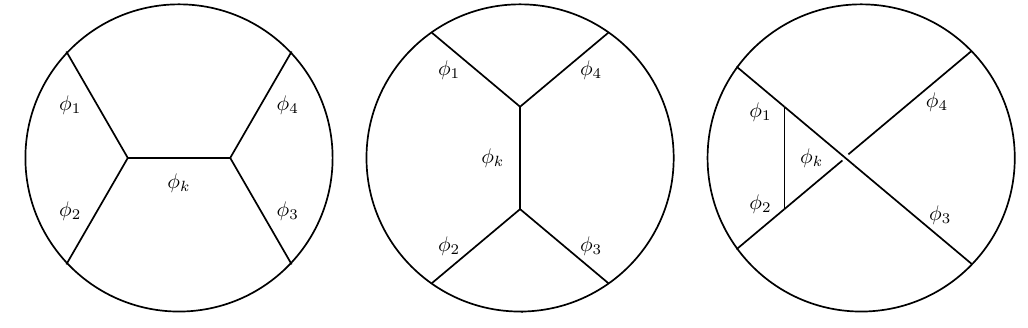
Figure 4 . s; t and u scalar exchange Witten